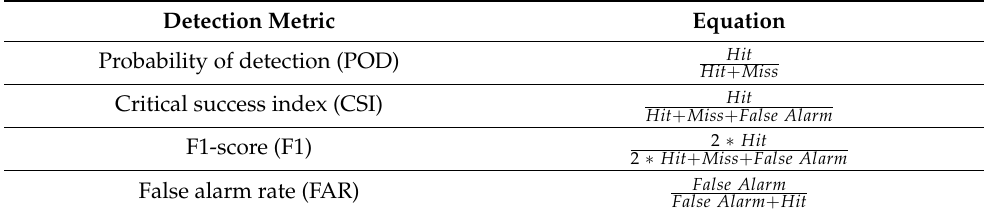
Table 3. Table of detection metrics and